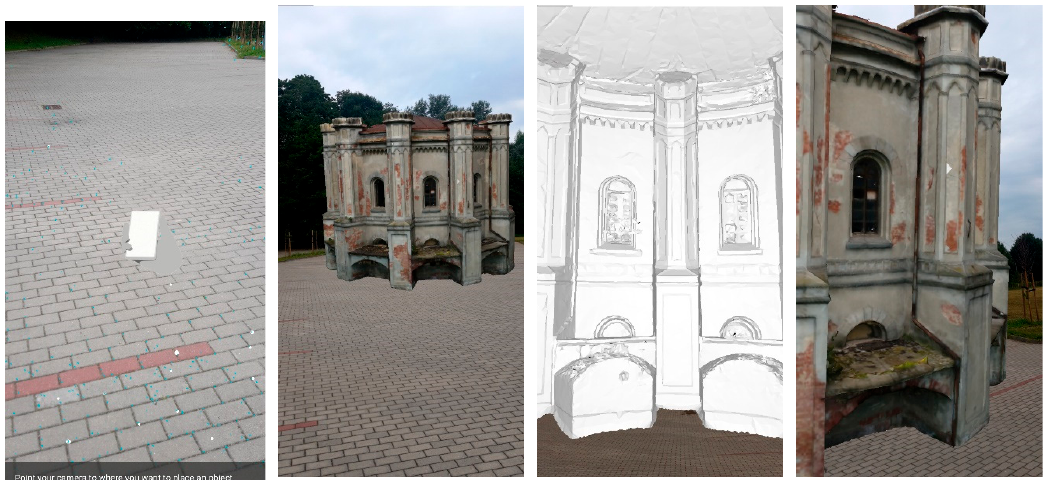
Figure 16. Visualization of the 3D water station building model in prototype AR application—100k model (from the left surface recognizing, walking near 3D model of Water Station (real sizes), view from inside the building, view from near the building). Test carried out in the parking lot in Olsztyn on the UWM campus.